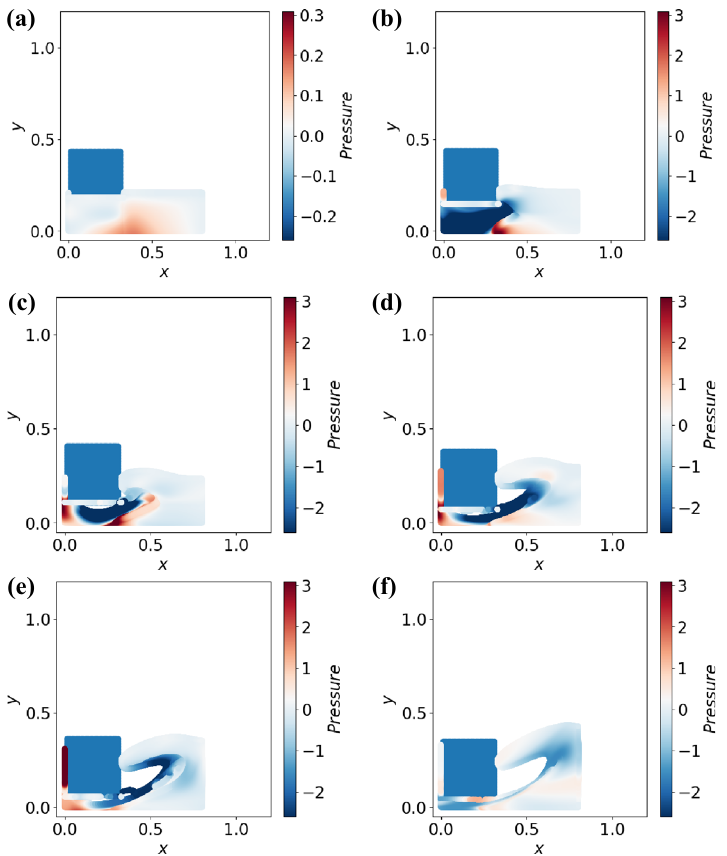
Fig. 5 The surge morphology and pressure distribution diagram. Water depth D = 0 . 21 m and particle density n = 200 / m. Each map corresponds to a different moment. a 2 dt. b 4 dt. c 6 dt. d 8 dt. e 9 dt. f 10